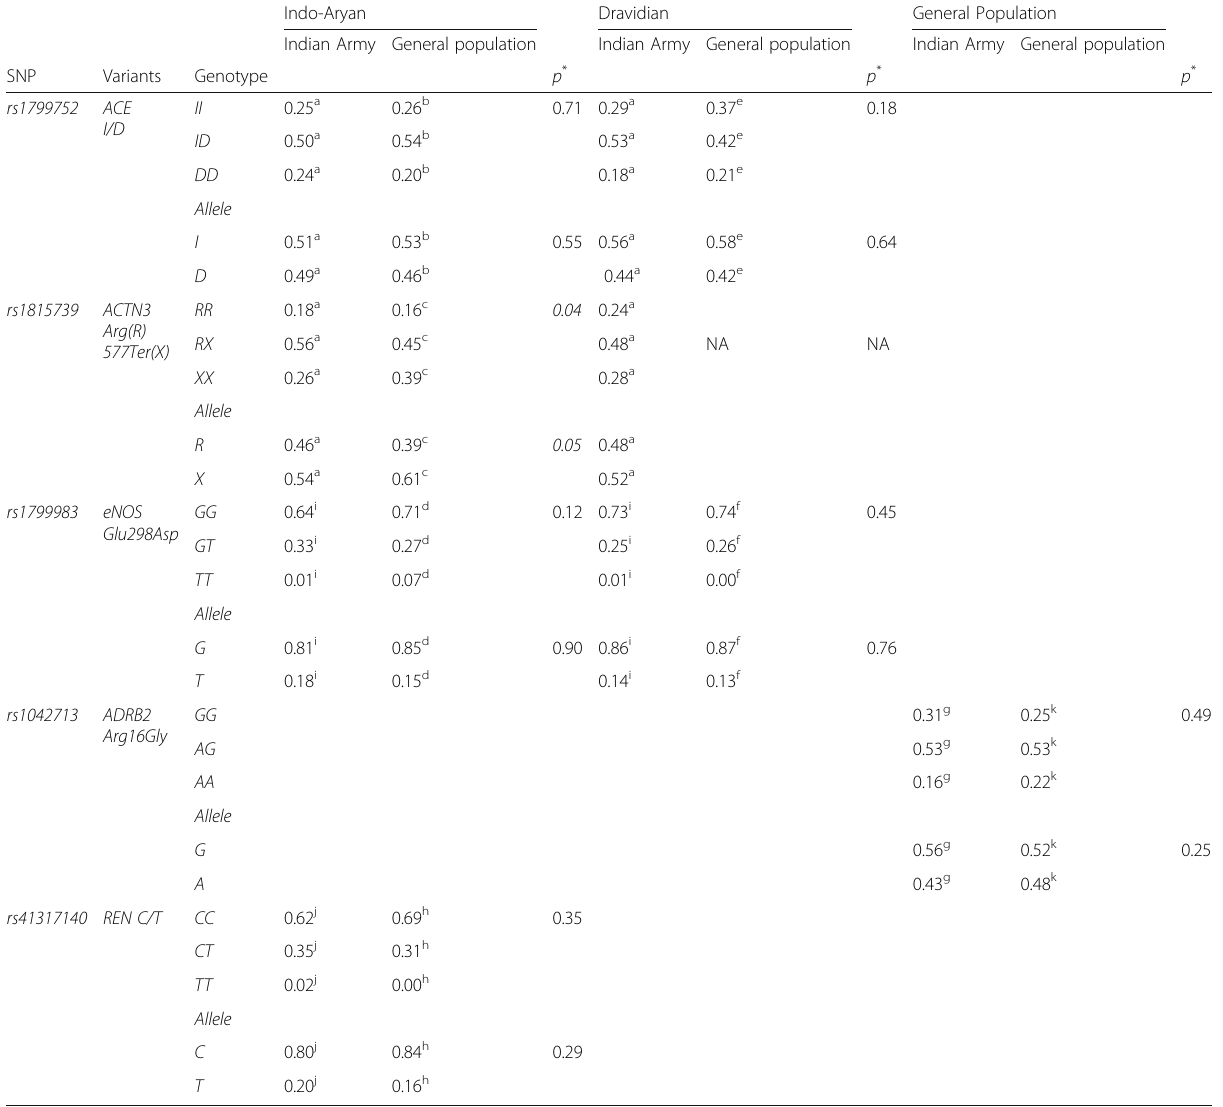
Table 9 Comparison of genotypic and allelic frequency distribution between participants of the Indian Army and general Indian population